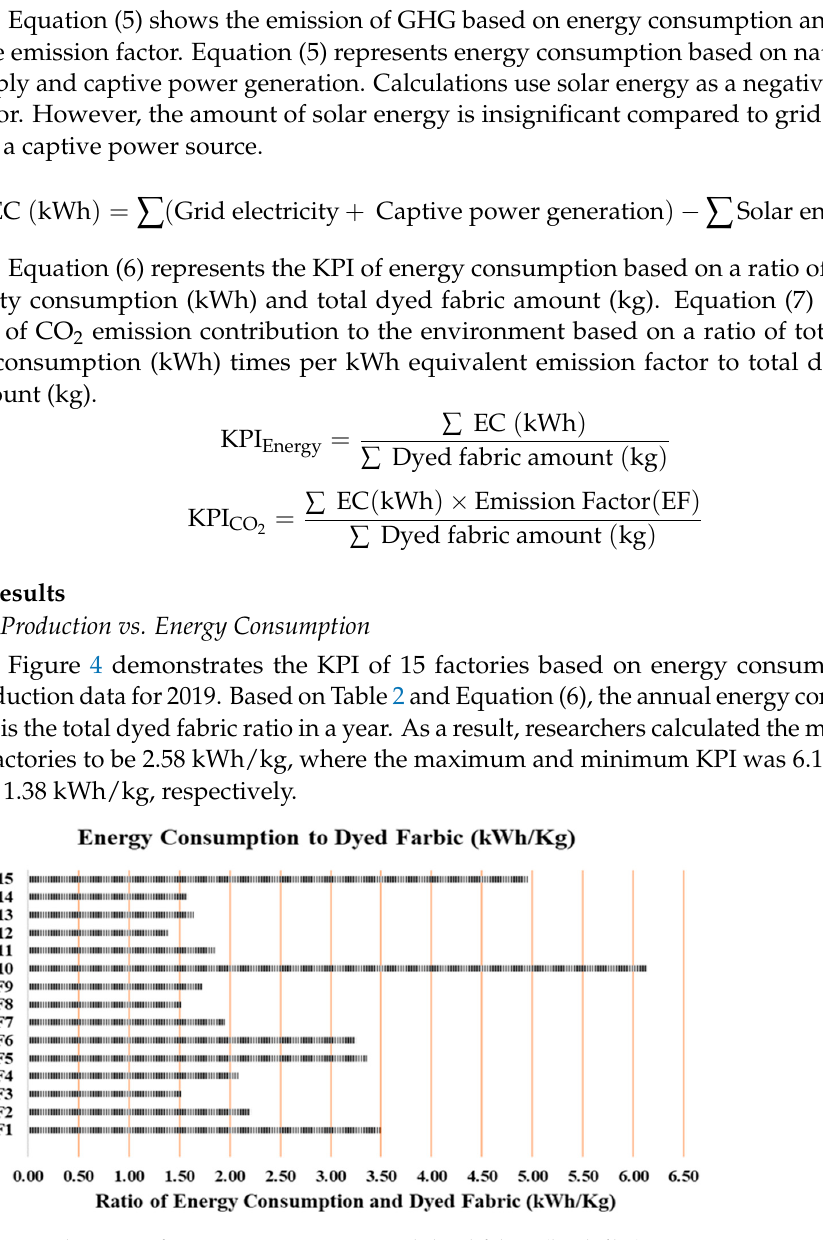
Figure 4. The ratio of energy consumption and dyed fabric